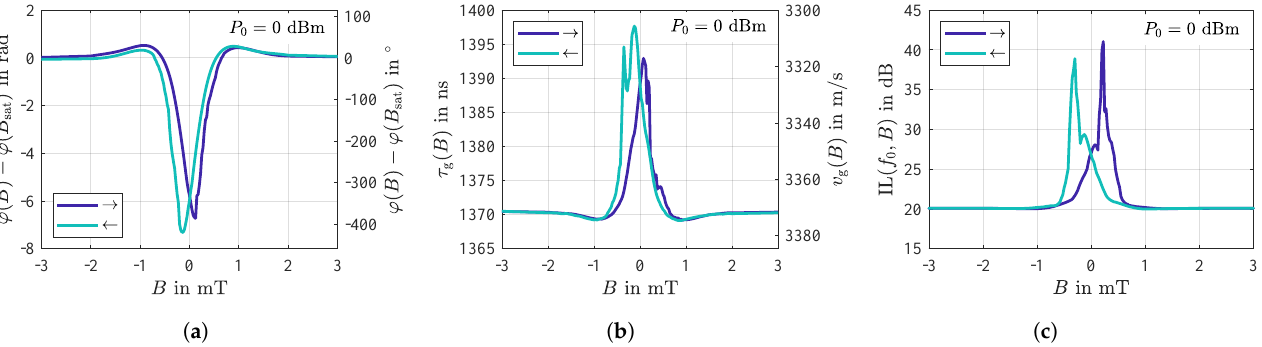
Figure 6. Phase response ( a ), group delay and group velocity ( b ), and insertion loss ( c ) of the SAW delay line sensor obtained from a series of measurements of the two-port scattering parameters for various static magnetic flux densities B . The results of all three sub-figures are based on data from the same series of measurements which was performed for an input power of the sensor of P 0 = 0dBm and at or around, respectively, its synchronous frequency of f 0 =